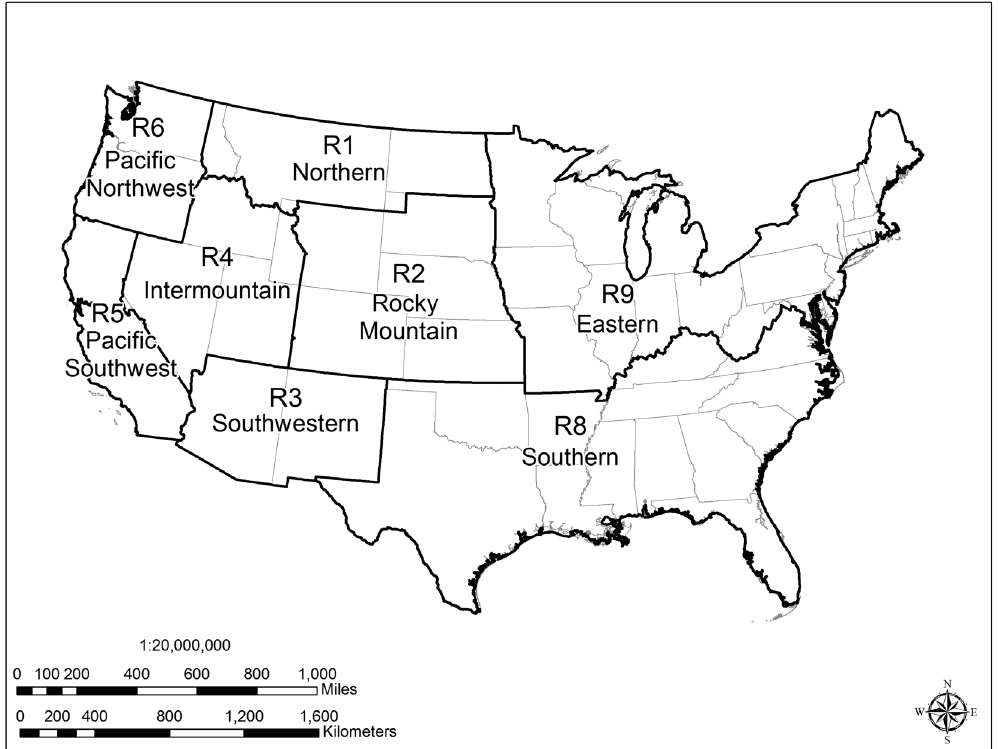
Figure 2. Forest Service Region numbers and names for the continental United States.